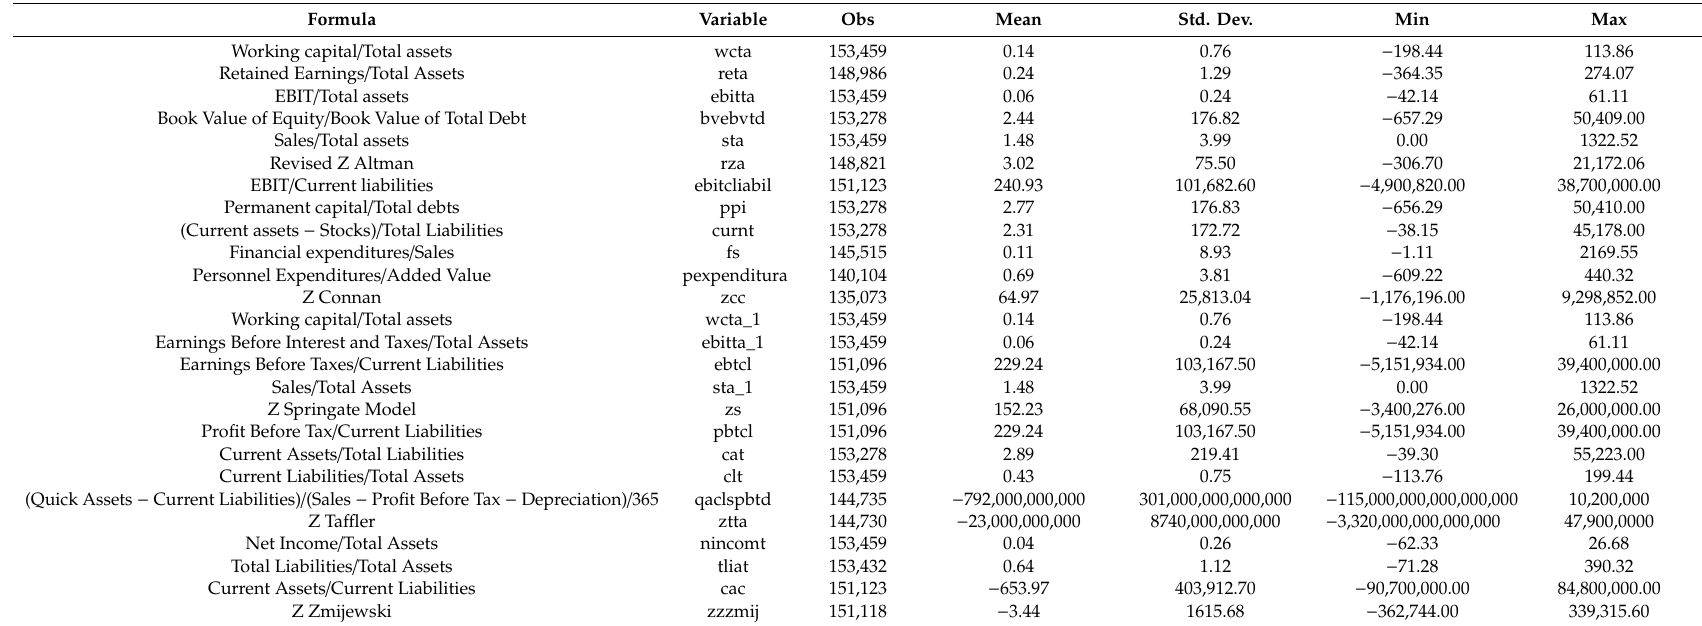
Table 2. Variables, formulas, and descriptive